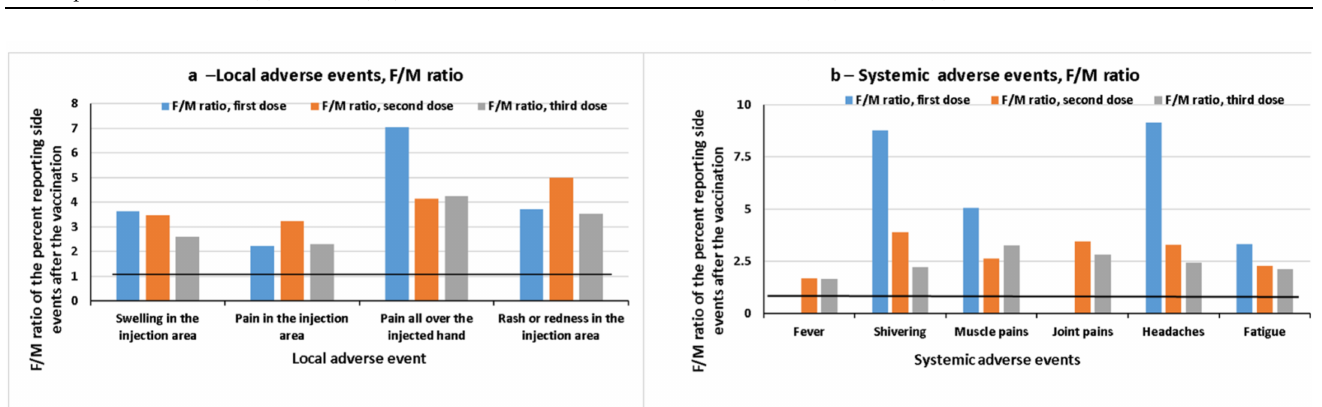
Figure 3. Female-to-male ratio of the percentage reporting local and systemic adverse events after three doses of